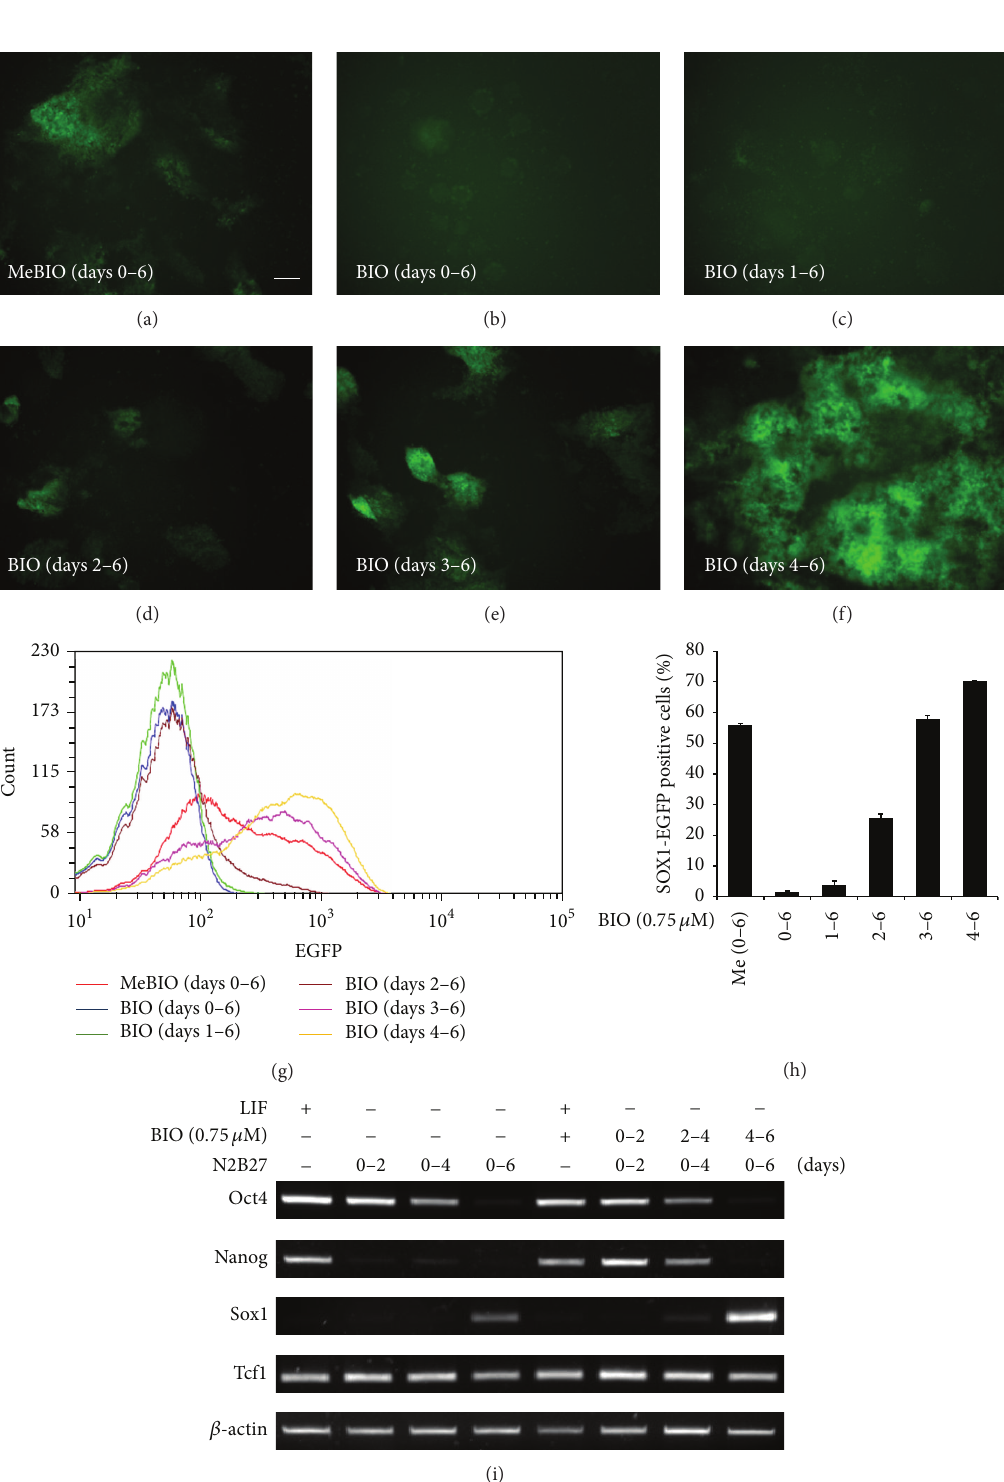
Figure 3: Increase in neural differentiation of precursor cells by GSK3 𝛽 inhibitor (BIO) during days 4 to 6 in N2B27 medium. (a)–(f) 46C ES cells were cultured in N2B27 medium for 6 days. GFP expression was elevated by BIO treatment (0.75 𝜇 M) from days 4 to 6, whereas GFP expression was reduced by BIO treatment (0.75 𝜇 M) from days 0 to 3. (g) FACS analysis of Sox1 -GFP expression during monolayer differentiation in N2B27 medium. (h) Proportions of Sox1 -GFP expressing cells as determined by FACS. (i) RT-PCR analysis showed that Nanog and Sox1 expression were elevated by BIO treatment (0.75 𝜇 M) under nondifferentiation and neural differentiation conditions, respectively. Scale bars, 100 𝜇